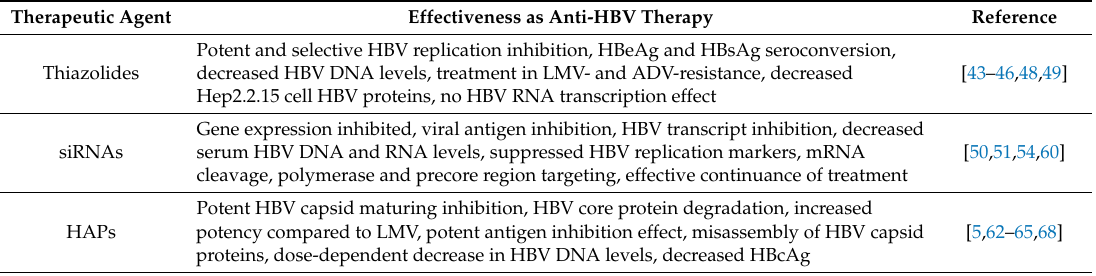
Table 2. Summary of anti-HBV thiazolide, siRNA, and HAP therapeutic agents as a treatment plan. Therapeutic Agent Effectiveness as Anti-HBV Therapy